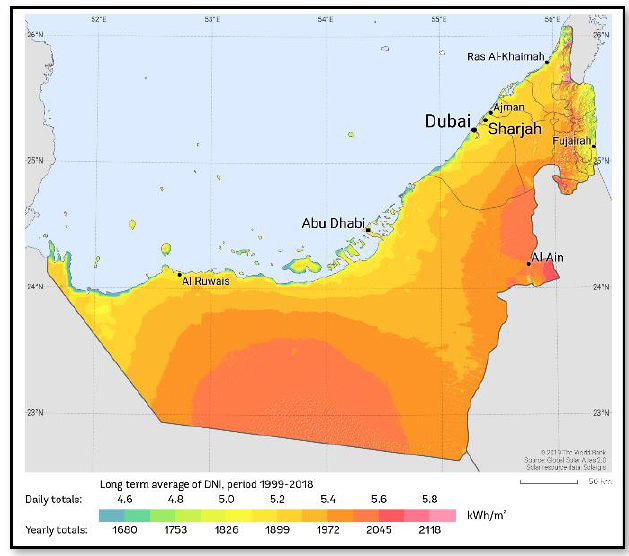
Figure 4. UAE map of Global Horizontal Irradiation (GHI) [48,49].